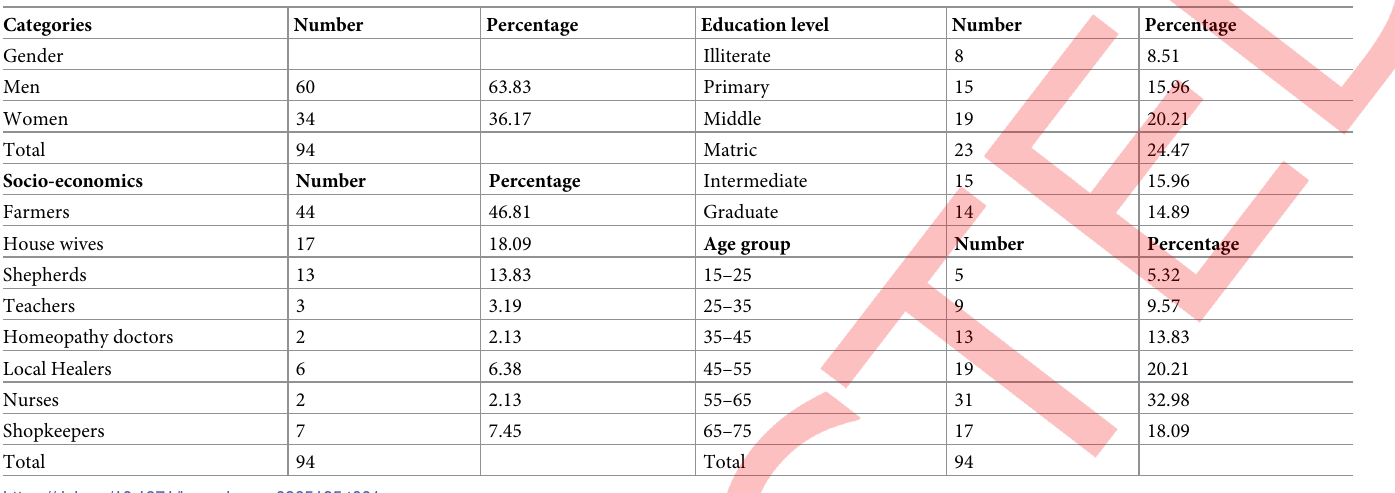
Table 1. Demographic data of